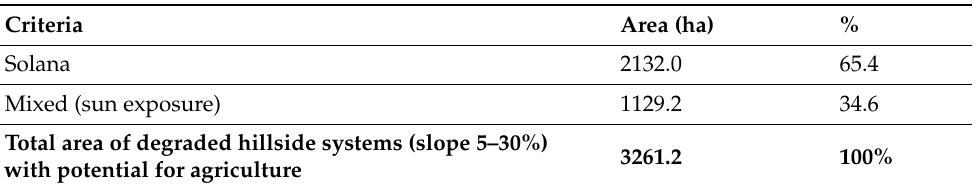
Table 6. Exposure of degraded hillside systems (slope 5–30%) with potential for agriculture after applying all the criteria described above.